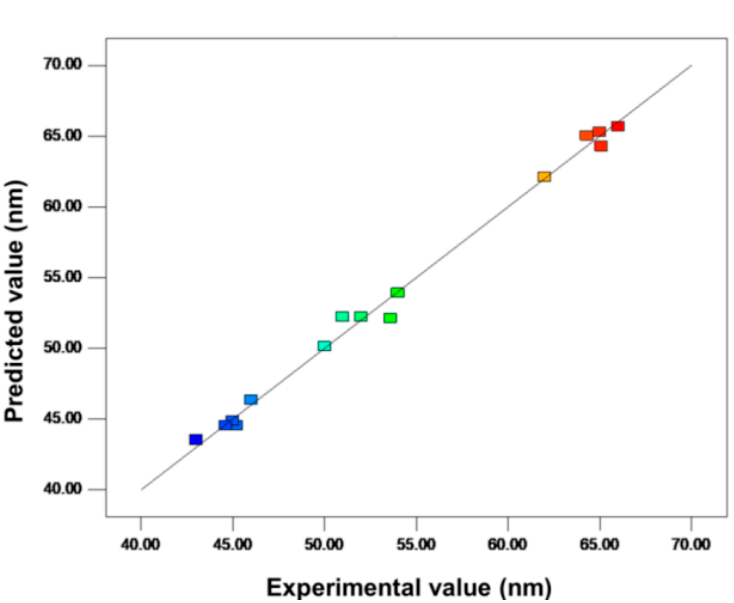
Table 2. ANOVA for response surface reduced quadratic model.